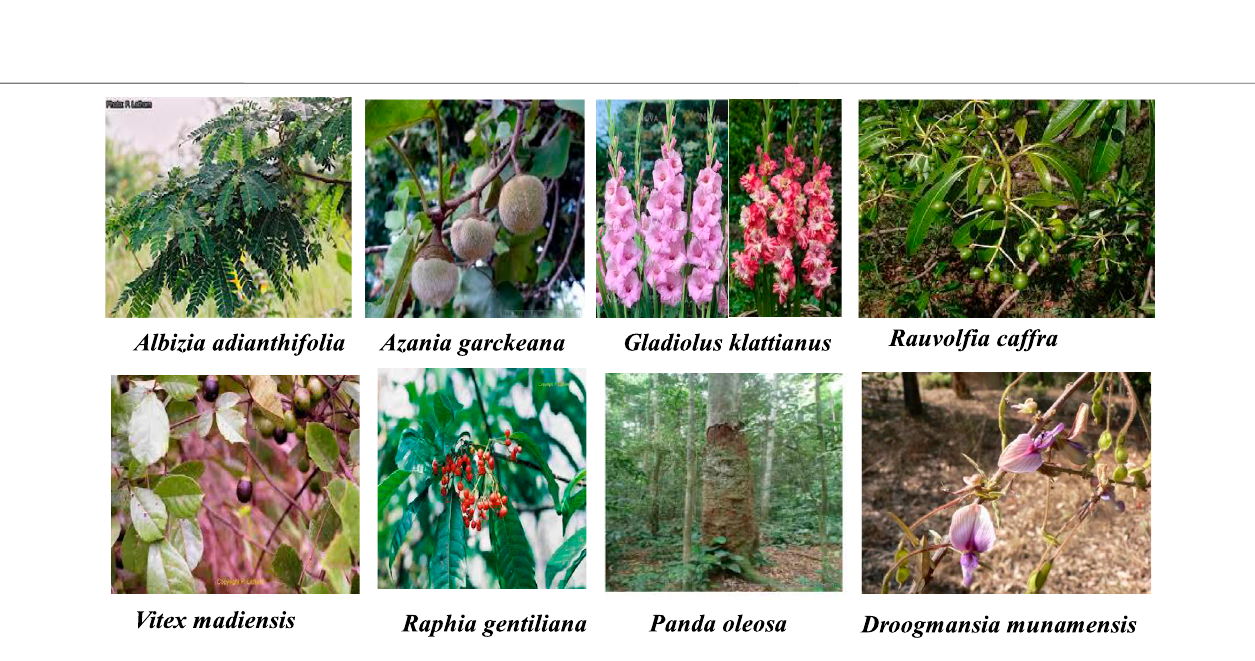
FIGURE 5 | Plants that underwent experimental pharmacology inside DRC.